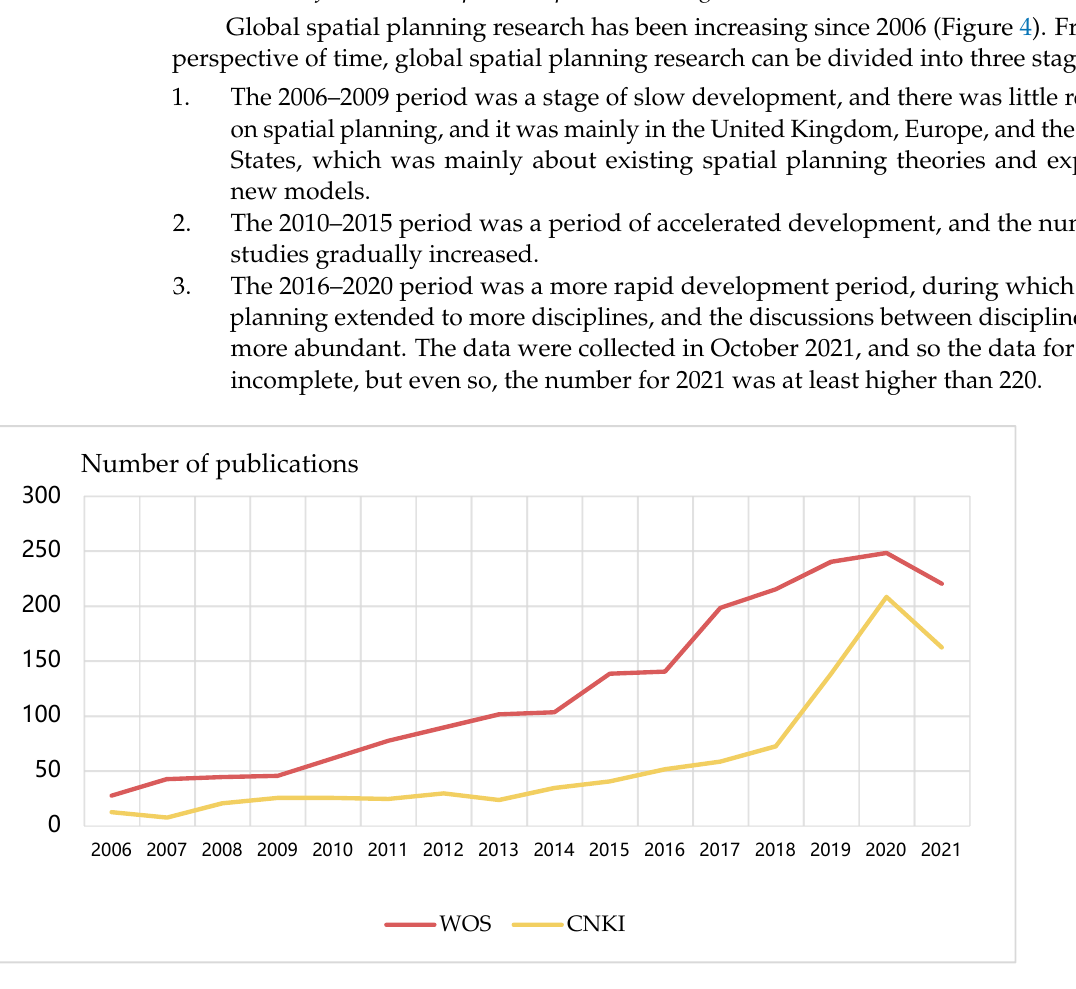
Figure 4. The number of published papers on spatial planning (2006–2021).